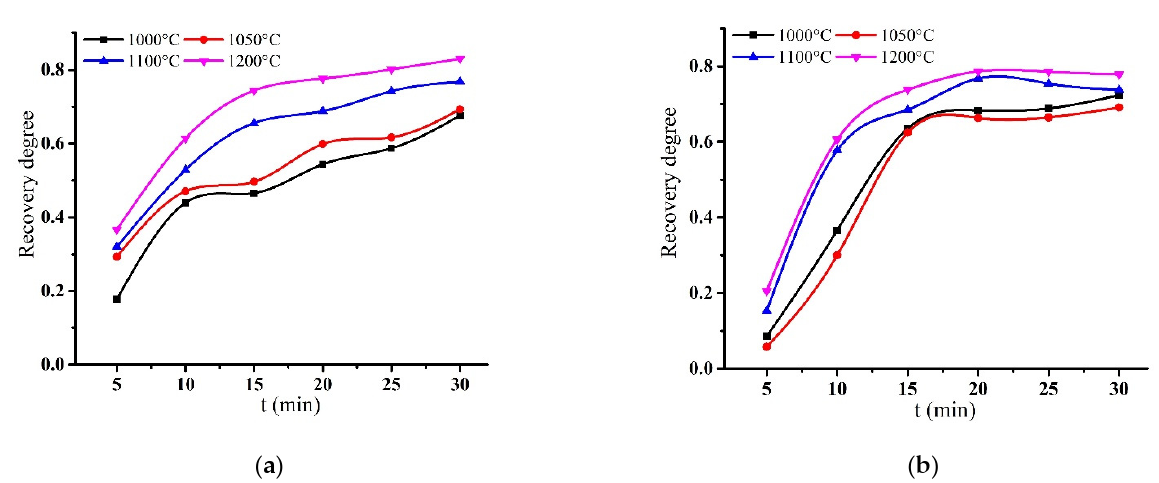
Figure 1. Influence of time and temperature in the RM carbothermic reduction on the iron recovery degree without additives ( a ) and with 13.65% Na 2 SO 4 ( b ).